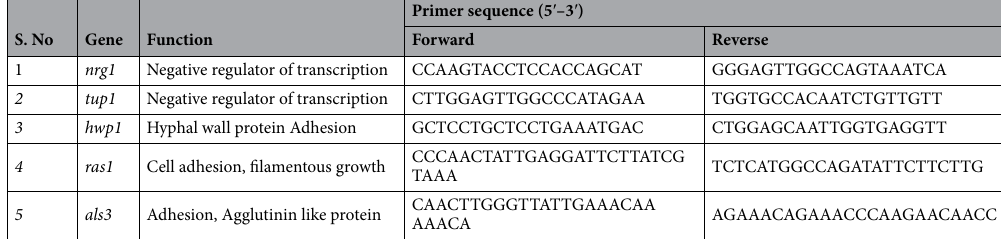
Table 1. List of the genes, their function and corresponding primer sequence used in the current